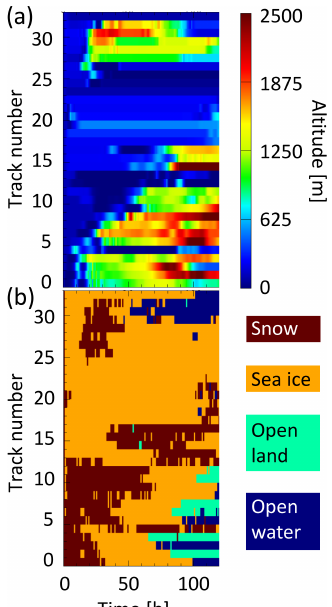
Figure 4. Exemplary results from the analysis of the IMS maps for the filter collected in Alert starting 10 June 2015. In both panels, each row (indicated as track number) represents one trajectory go- ing back in time for 5d, starting from 0 (when sampling took place), and displaying 120 separate time steps. The colors indicate the al- titude of the air mass for the different time steps in panel (a) and the respective nature of the ground at the location of the air mass in panel (b) .